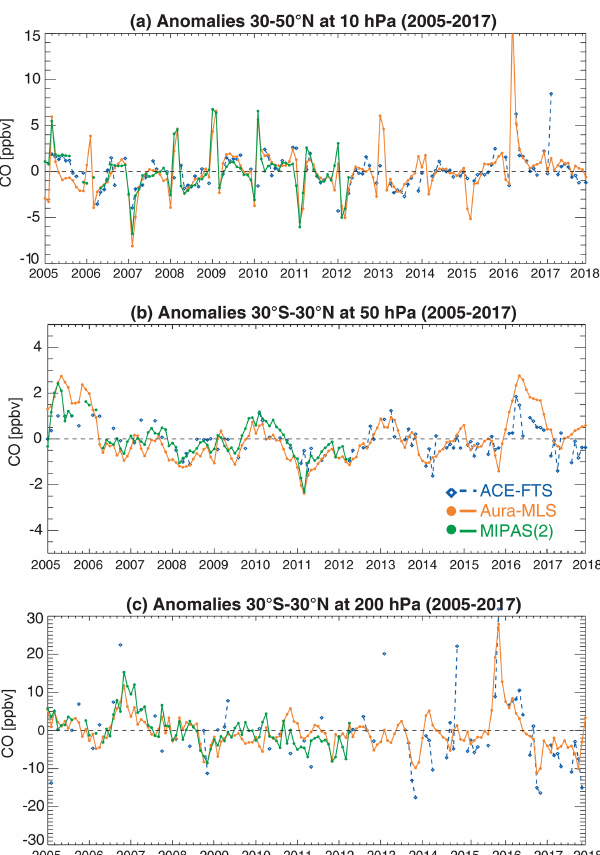
Figure 11. Deseasonalized CO anomalies from ACE-FTS, MI- PAS(2), and Aura-MLS are shown for 30–50 ◦ N at 10hPa (a) , and 50hPa (b) and 200hPa (c) for 30 ◦ S–30 ◦ N and the time period